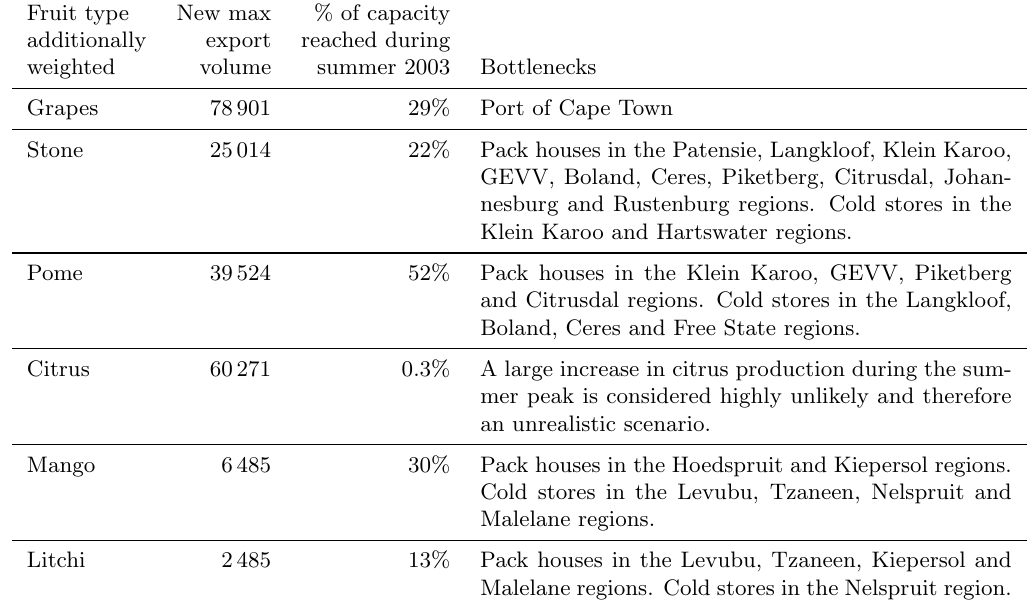
Sensitivity analysis of the weekly maximum export volume (measured in number of pallets) of each of the six summer fruit types (if all other fruit export volumes were to remain at 2003 export levels), with only the port of Cape Town as infrastructure exit point. not important. A breakdown of the results (for each fruit group) for the multi-commodity model maximum flow solution is shown in Table 7.